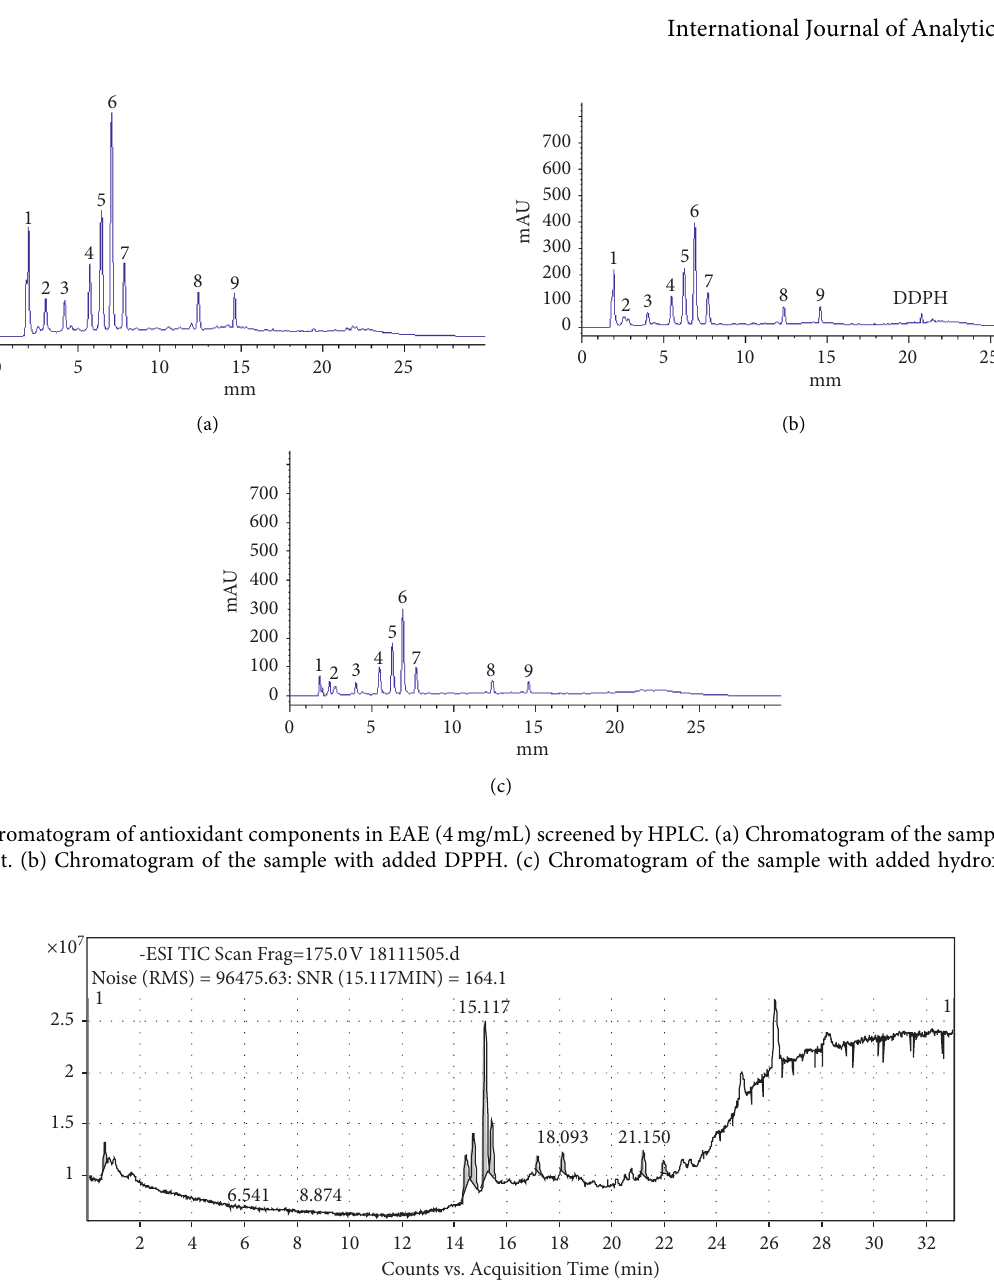
Figure 6: Total ion current diagram of EAE (4mg/mL).